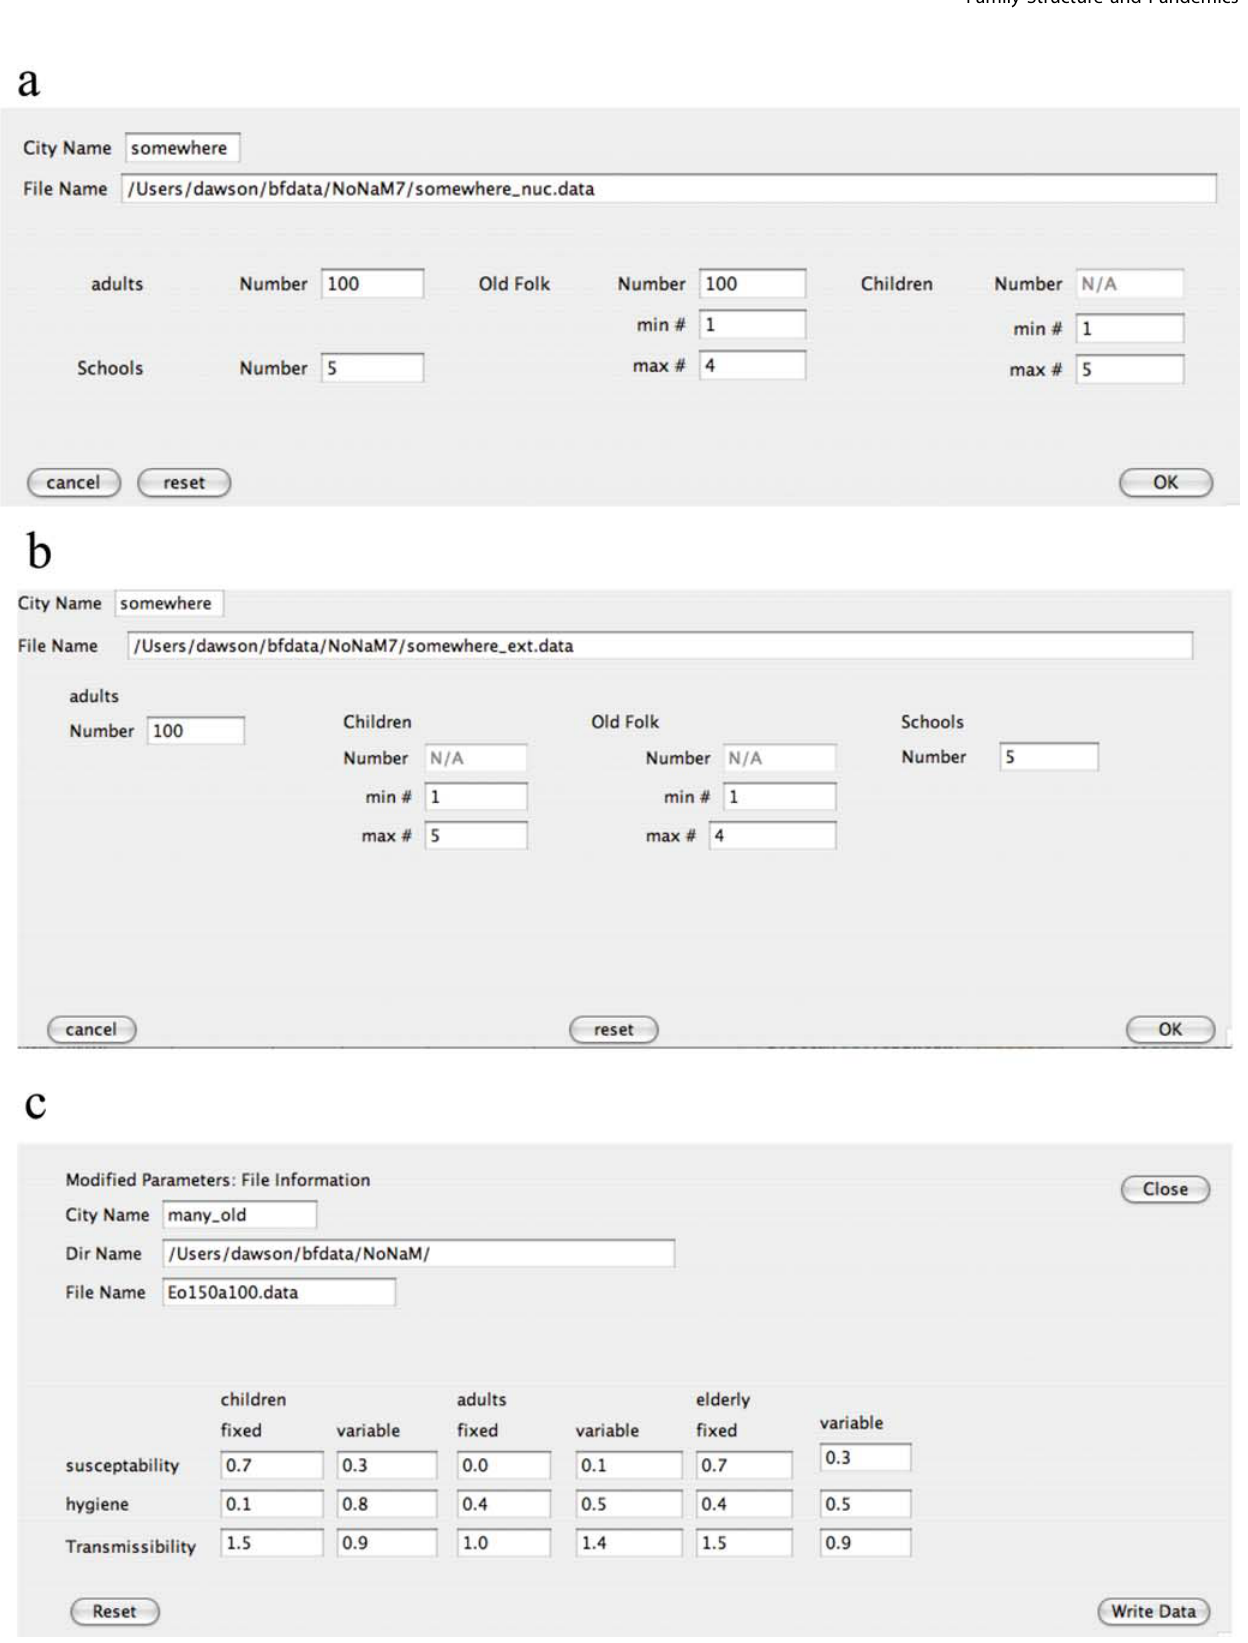
Figure 2. Example of the option menus used to build the cities and to establish infection profiles. (a) Option menu for building nuclear families. (b) Option menu for extended families. (c) Option menu for adjusting the infection profile of the individuals.